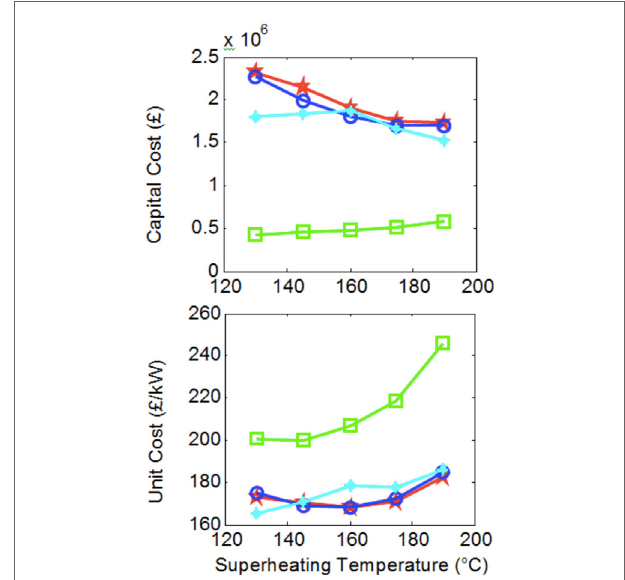
FiGURe 8 | System costs corresponding to Figure 7, over a range of maximum cycle temperatures, T 3 .